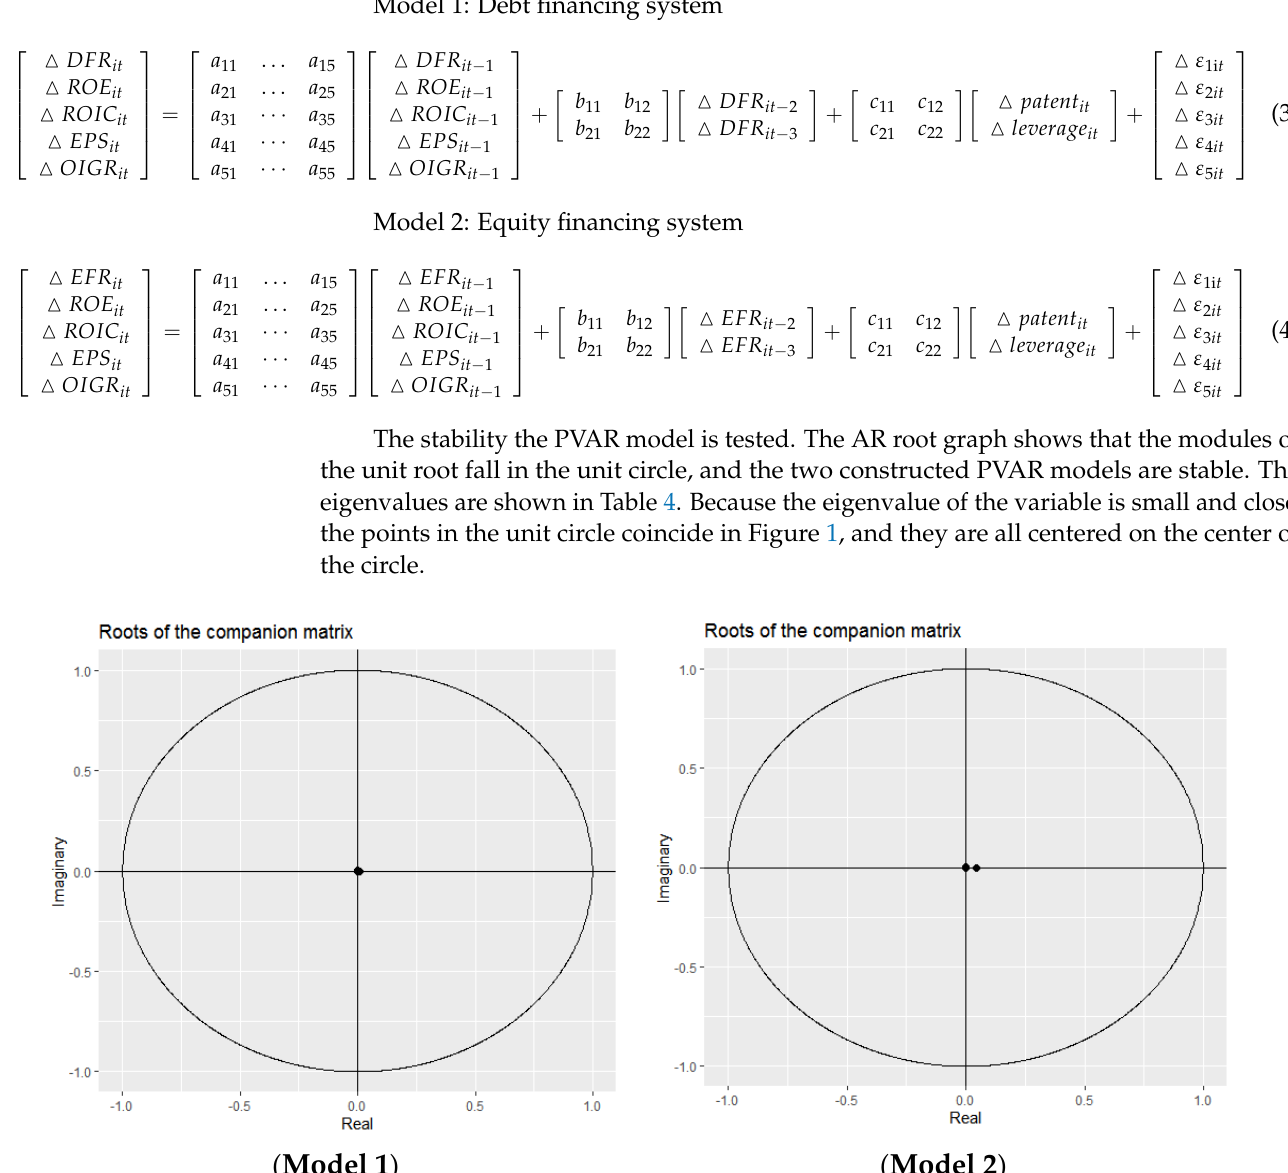
Figure 1. Stability graph of model 1 and model